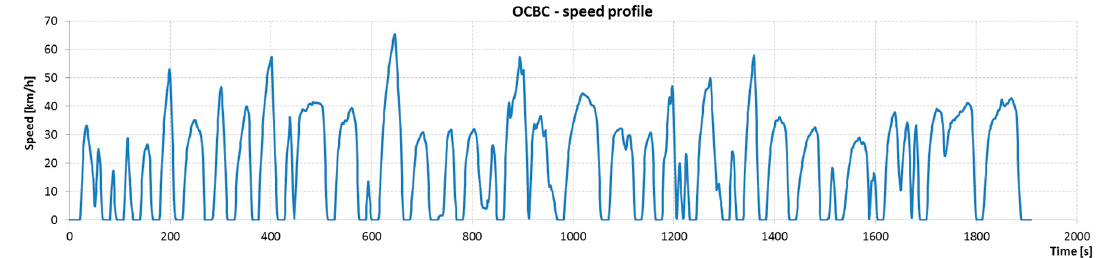
Figure 16. OCBC driving cycle.